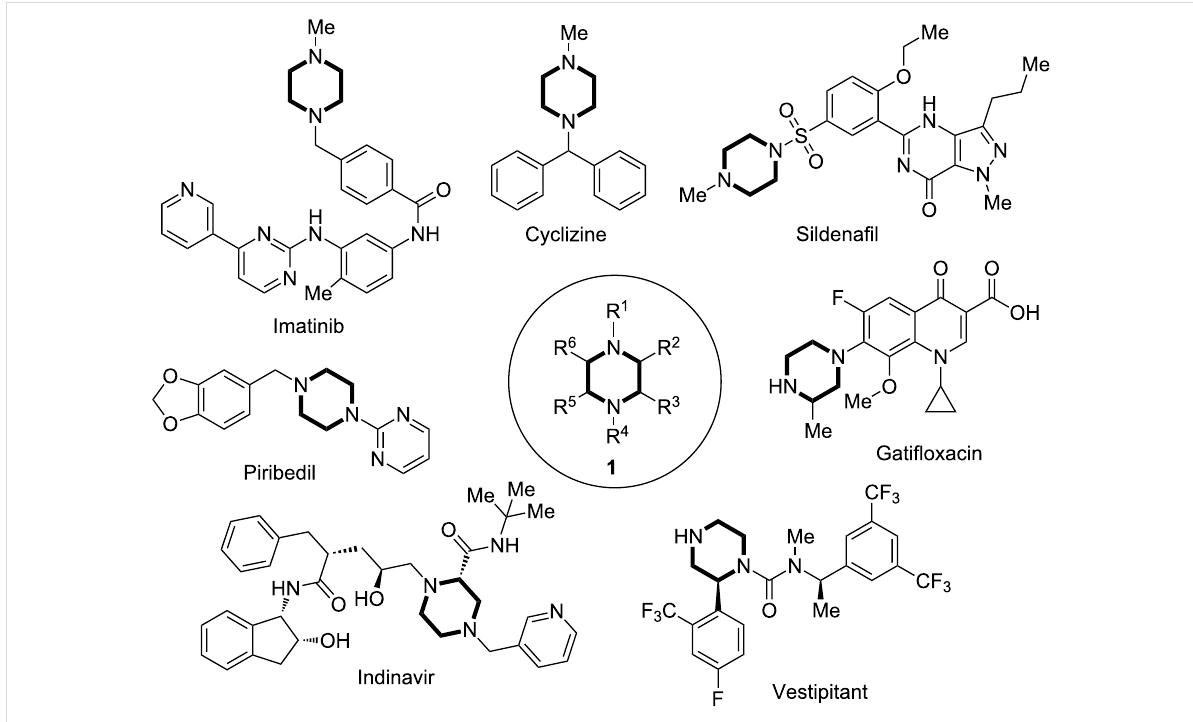
Figure 1: Selected piperazine-containing small-molecule pharmaceuticals.